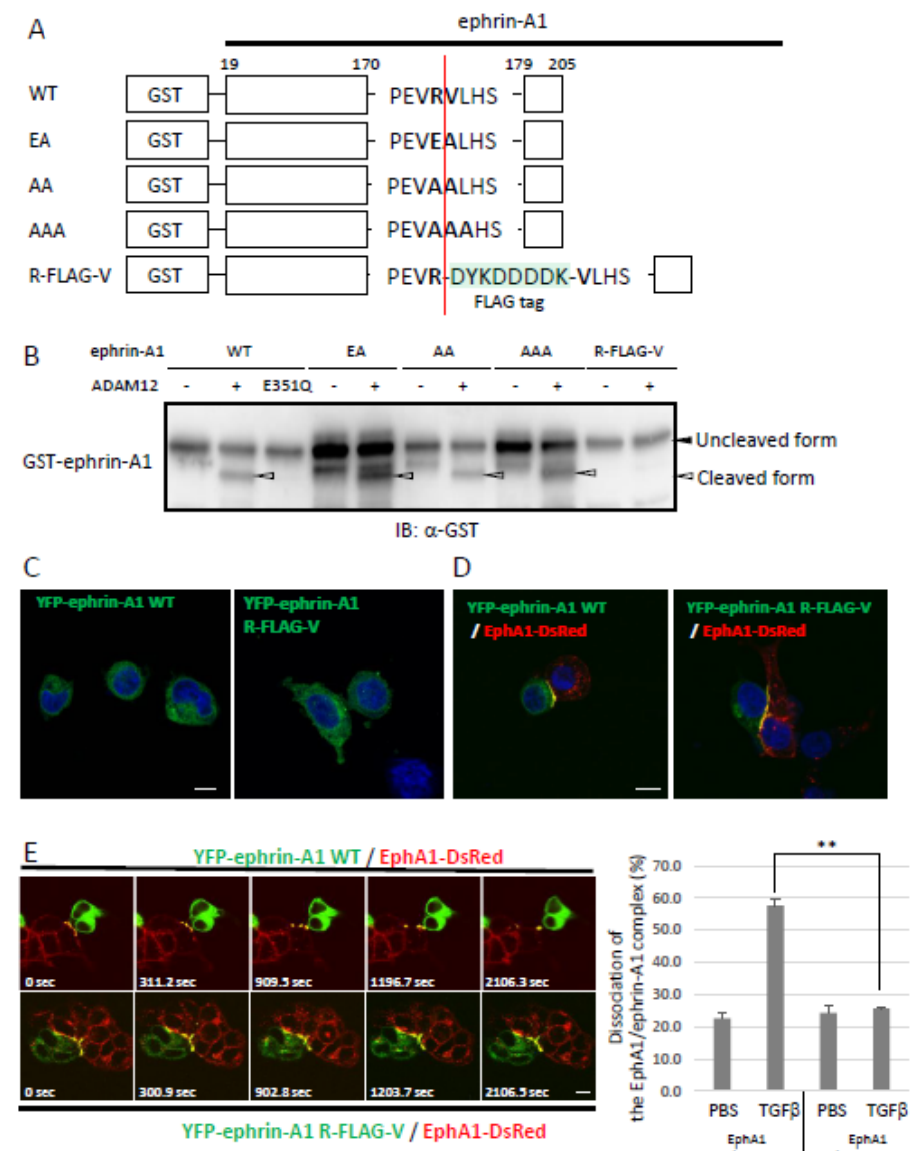
Figure 2. Mutational analysis of ADAM12-mediated ephrin-A1 cleavage. ( A ) A schematic presentation of ephrin-A1 mutants. ( B ) Effects of mutations in ephrin-A1 on ADAM12-mediated cleavage. Ephrin-A1 R-FLAG-V mutant was defective in ADAM12-mediated cleavage. ( C ) Subcellular localization of ephrin-A1 WT and R-FLAG-V mutant. HEK293 cells were transfected with YFP-ephrin-A1 WT or YFP-ephrin-A1 R-FLAG-V and observed by a confocal microscope. Both ephrin-A1 mutants showed similar subcellular localization in sparsely cultured conditions. ( D ) Binding capability of ephrin-A1 R-FLAG-V mutant against the EphA1 receptor. Co-localization of DsRed-tagged EphA1 and YFP-fused ephrin-A1 R-FLAG-V was found at cell boundaries and was equivalent to wild-type of ephrin-A1. Blue color shows DAPI signals. ( E ) Ephrin-A1 cleavage by ADAM12 in response to TGF- β stimulation and the quantification. Co-culture of EphA1-DsRed expressing cells and either YFP-ephrin-A1 WT or YFP-ephrin-A1 R-FLAG-V expressing cells was treated with 5 ng/mL TGF- β . Time-lapse images were obtained by a confocal microscope. Scale bars: 10 µ m. Co-culture of EphA1-DsRed expressing cells and either YFP-ephrin-A1 WT or YFP-ephrin-A1 -R-FLAG-V expressing cells was treated with 5 ng/mL TGF- β . Dissociation of the EphA1/ephrin-A1 complex was counted under a fluorescence microscope. ( n = 3, ** p < 0.01). Ephrin-A1 R-FLAG-V was defective in ADAM12-mediated cleavage induced by TGF- β